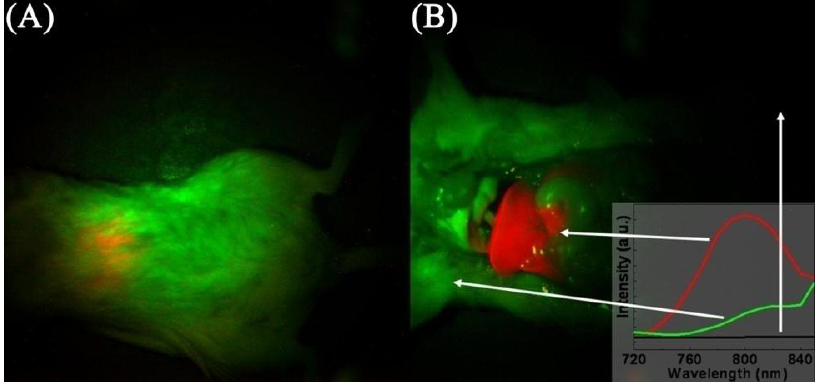
Figure 16. Images of mouse injected in vivo with UCNPs; before ( A ) and after dissection ( B ). The red color indicates emission from UCNPs, green and black show background as indicated by the arrows and the inset ([31,125], reproduced by permission of the American Chemical